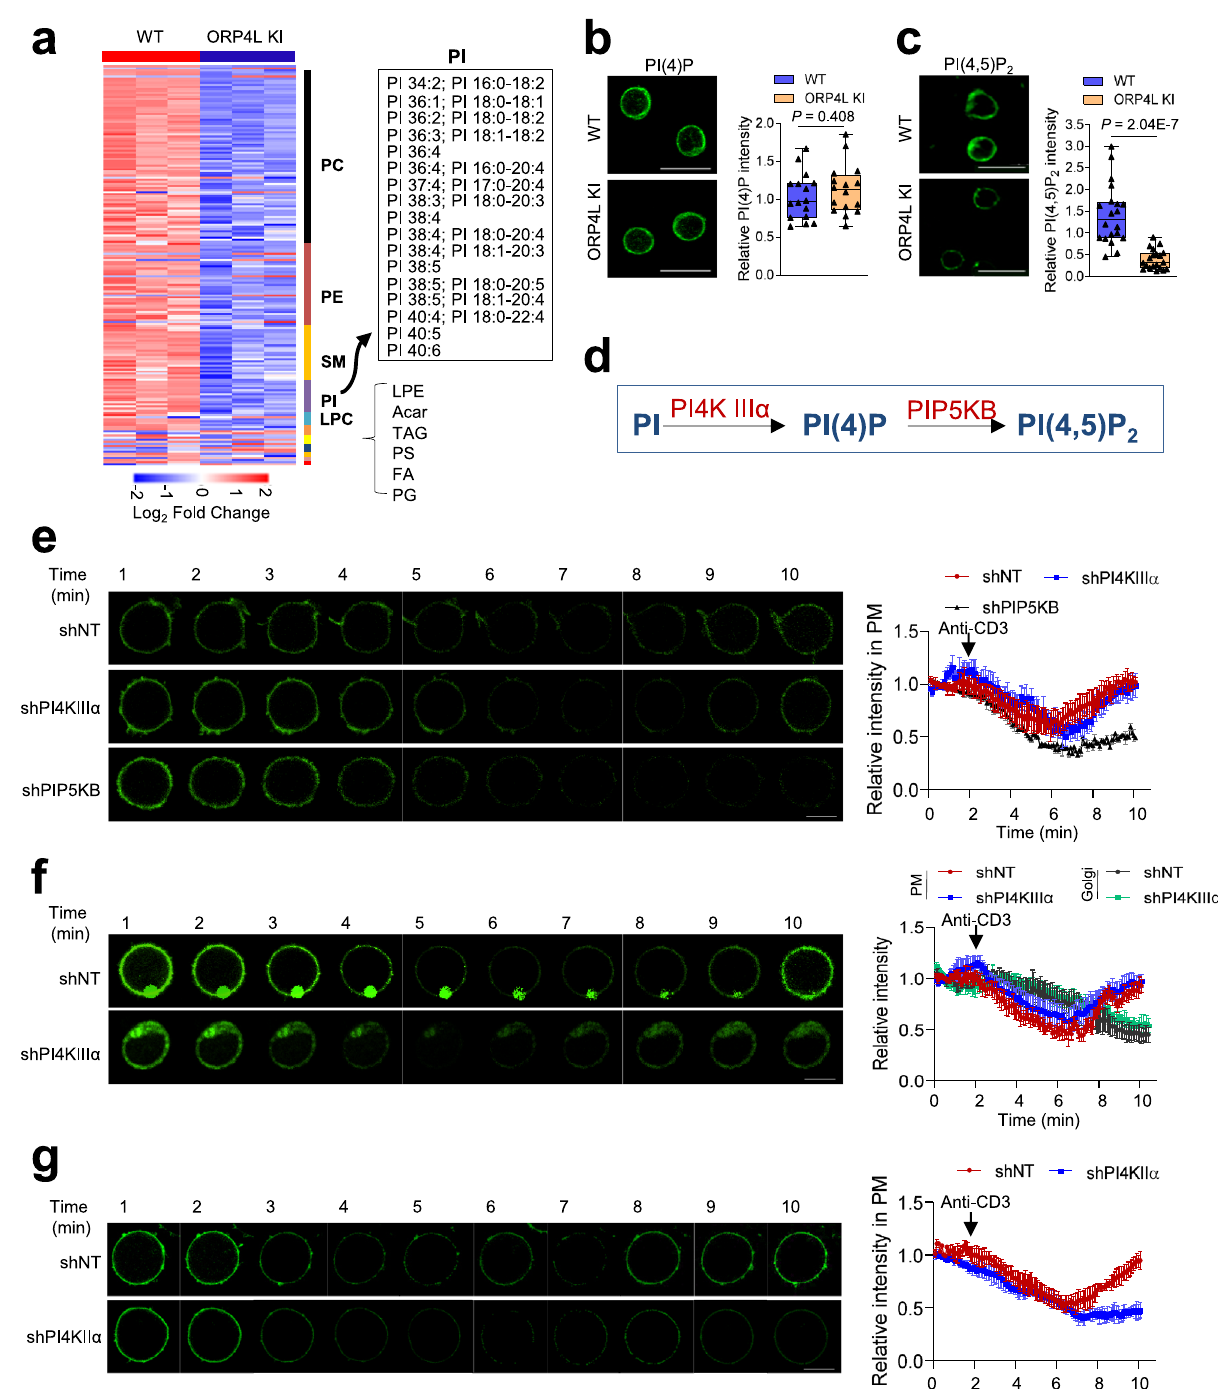
Fig. 1 | PM phosphoinositides are remodeled and PI(4)P in the Golgi is trans- portedtothePMinORP4LKIT-cells.a HeatmapofPMlipidchangesinT-cellsof ORP4LKIandlittermatewild-typemice( n =3mice). b , c PI(4)P( b )andPI(4,5)P 2 ( c ) contentsinT-cellsofORP4LKIandlittermatewild-typemice.Scalebar,10 μ m.The right panel indicates quantitation of relative fl uorescence intensity. Black triangles present in dividual data points for n =16 (panel b) and n =20 (panel c ) cells from one mouse. The same experiment was repeated twice in T-cells from two mice. d Schematic representation of PIPs metabolism in the PM. e Time course of PI(4,5) P 2 probeGFP-PH PLC δ 1 atthePMofORPL4KIT-cellssubjectedto PI4KIII α orPIP5KB knockdown. The right panel indicates quanti fi cation of relative fl uorescence intensity changes of GFP-PH PLC δ 1 at the PM. Scale bar, 5 μ m. f Time course of the PI(4)P probe GFP-P4M SidM at PM and Golgi complex of ORPL4 KI T-cells subjected